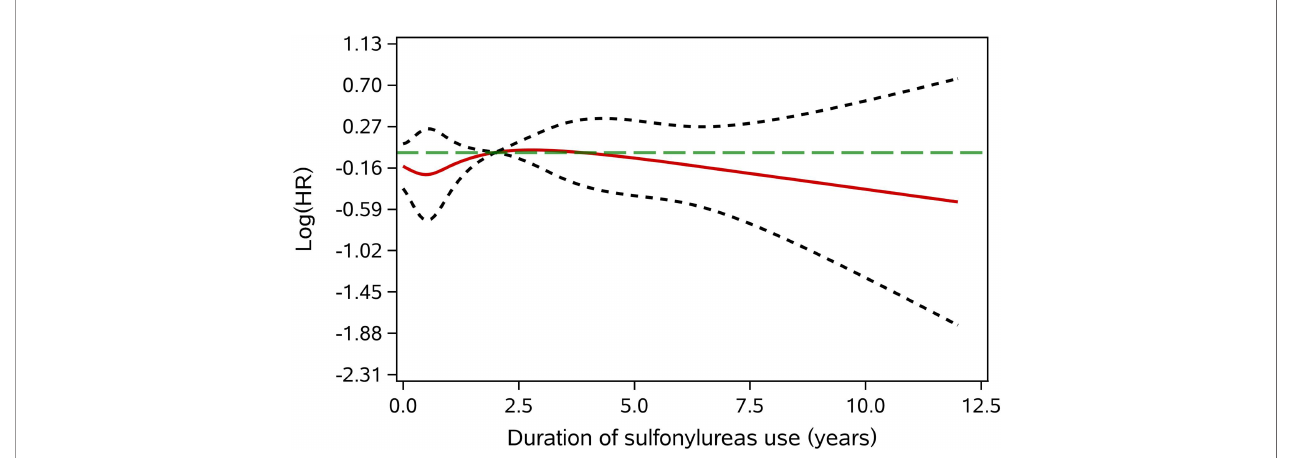
FIGURE 2 | Adjusted dose-response association between cumulative duration of sulfonylurea use and cancer risk. The green long dotted line is the null value (HR = 1). The red solid line represents the point estimate of the log(HR). The two gray short dash line are the limits of 95%CI. The reference value was the median of cumulative duration of sulfonylurea